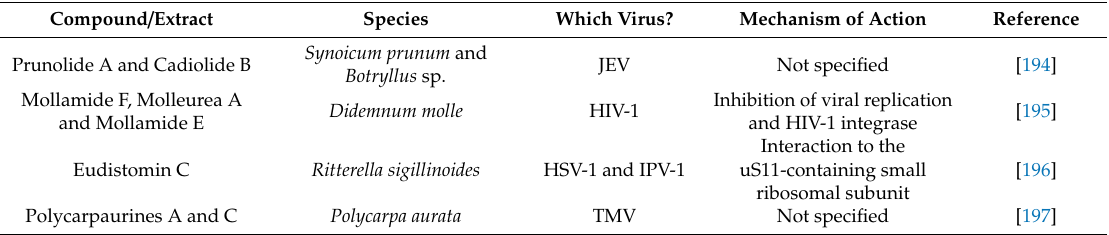
Table 11. The table report antiviral compounds / extracts from tunicates. HIV-1, Human Immunodeficiency virus 1; HSV-1, Herpes simplex virus 1; JEV, Japanese Encephalitis virus; IPV, Inactivated Polio vaccine; TMV, Tobacco Mosaic